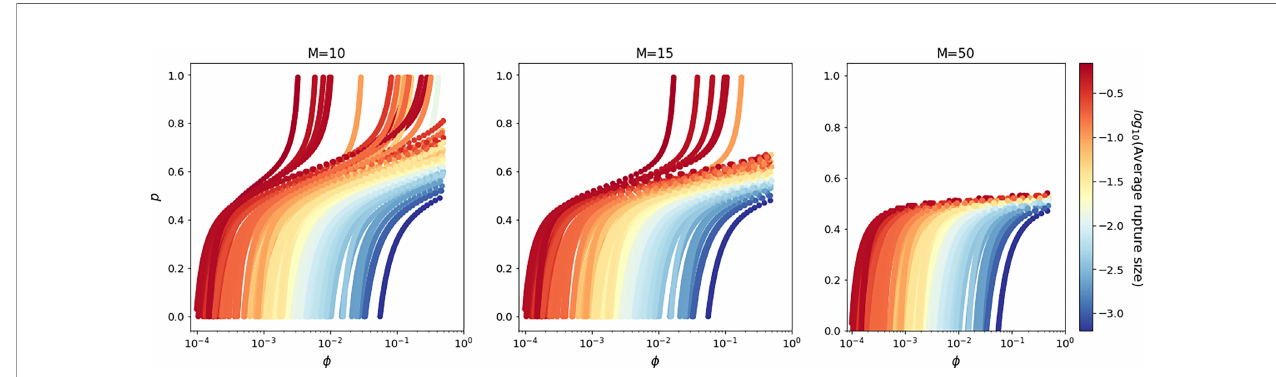
FIGURE 10 | Combination of parameter values for p and f that give r = 3.31 × 10 -5 , for three different values of the threshold number of bacteria, M = 10, 15, 50. The combinations are shown for different rupture size distributions, sampled from the posterior distribution of the intracellular model. The average of each rupture size distribution is indicated by the colour of